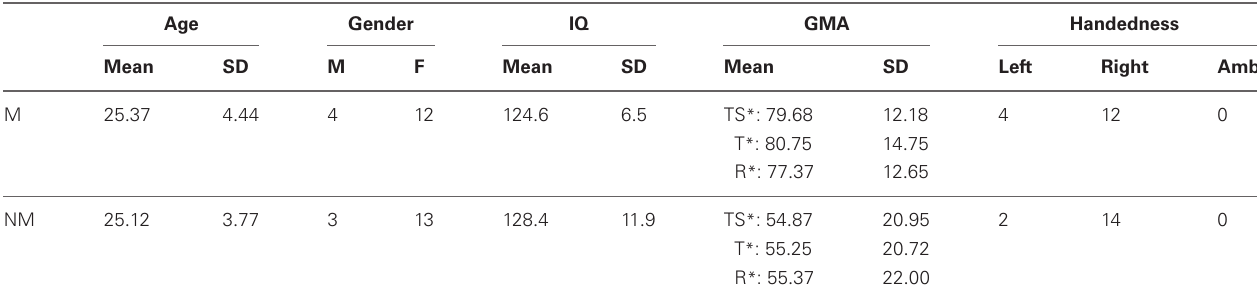
* Difference between experimental groups is significant at p < 0.001 [T TS (31) = 4.095; T T (31) = 4.009; T R (31) = 3.467; note that T-Tests were only applied to variables “Age,” “IQ,” and “GMA.” For “Gender” and “Handedness”, Chi-Square tests were used]. All statistical tests shown in this table were conducted